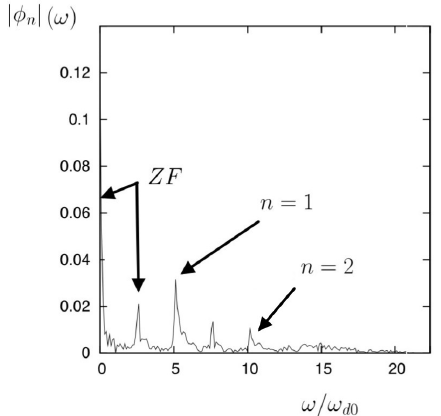
Figure 5. Continuing the presentation of results of the simulation shown in Figure 4, the spectrum in frequency of the electric potential is shown. We observe clearly both components of zonal flow (ZF), the quasi-zero part driven by the Reynolds tensor (fluid regime) and the low-frequency zonal flow (LFZF) component (in the kinetic regime), at a frequency close to ω ZF , num (cid:39) 2.5 ω d 0 .